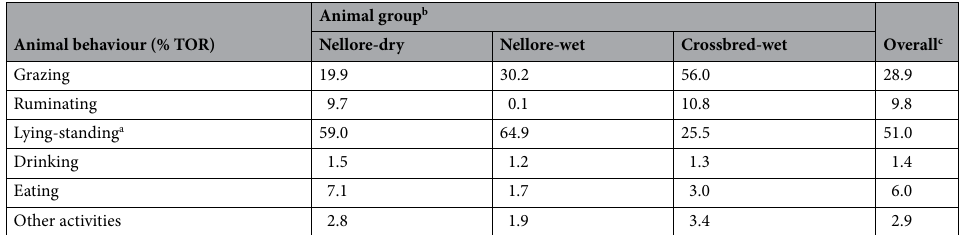
Table 1. Types of animal behavior (grazing, ruminating, lying-standing, drinking, eating and other activities) as percentages of the total observation record (TOR), from visual observation in loco + video records during both seasons (dry and wet). a Lying-standing: activities of lying down + standing up. b Animal groups: Nellore- dry: Nellore animals finished during dry season; Nellore-wet: Nellore animals reared during the wet season; Crossbred-wet: crossbred animals reared during the wet season. c Overall: percentage of each type of animal behavior, considering during both phases (rearing and finishing phases) and both seasons (wet and dry seasons).